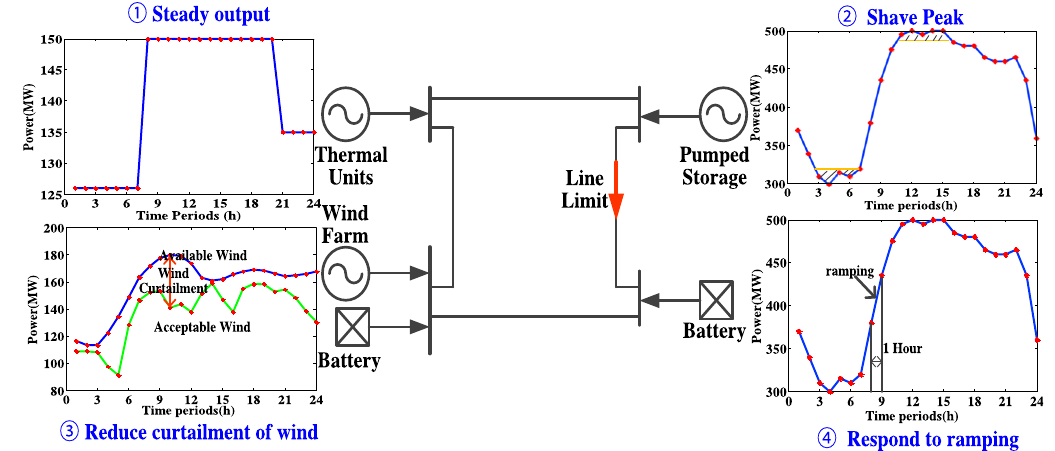
Fig. 1 Positive roles of pumped-storage and battery